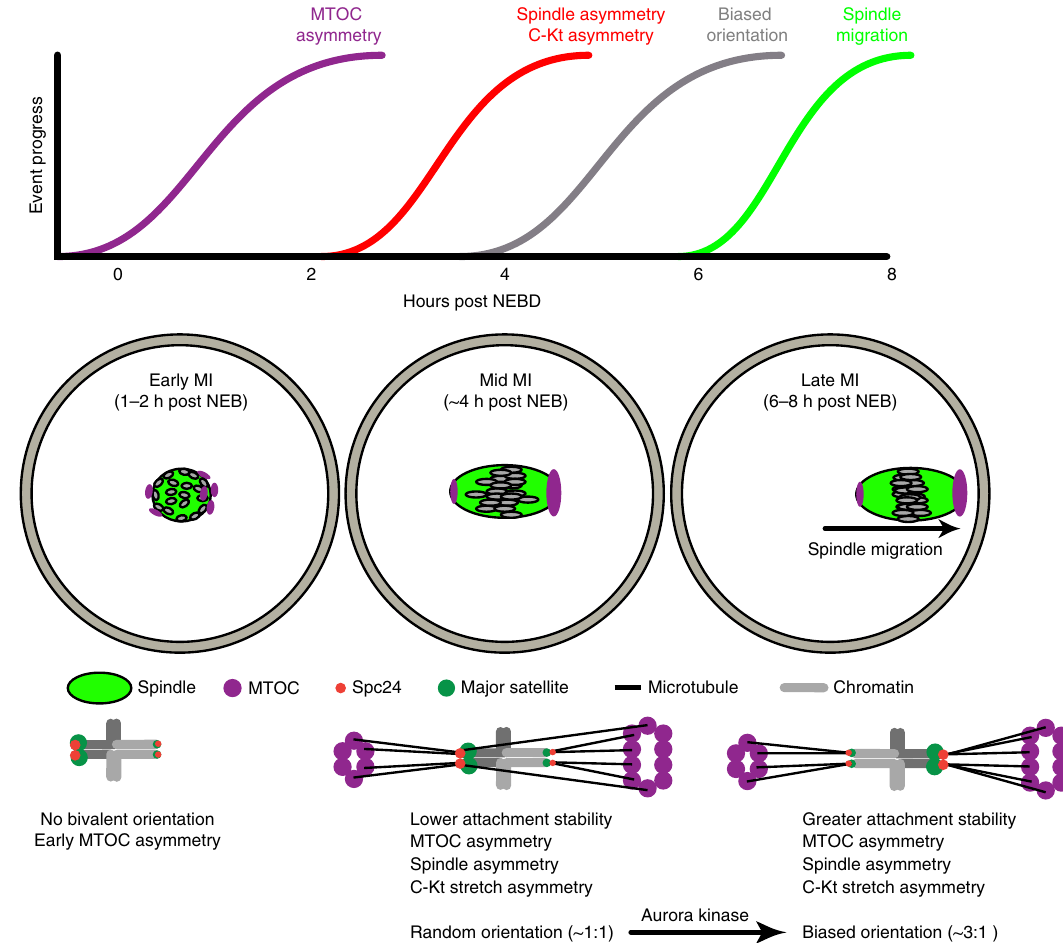
Fig. 7 Schematic to demonstrate meiotic drive, showing the mechanism of asymmetric bivalent reorientation. The schematic shows the approximate relative timings of events relating to meiotic drive and spindle migration in times relative to NEBD (top). Cartoons graphically depict the events taking place in early, mid and late MI from left to right, respectively, in the oocyte (middle) and at the level of an individual bivalent experiencing meiotic drive